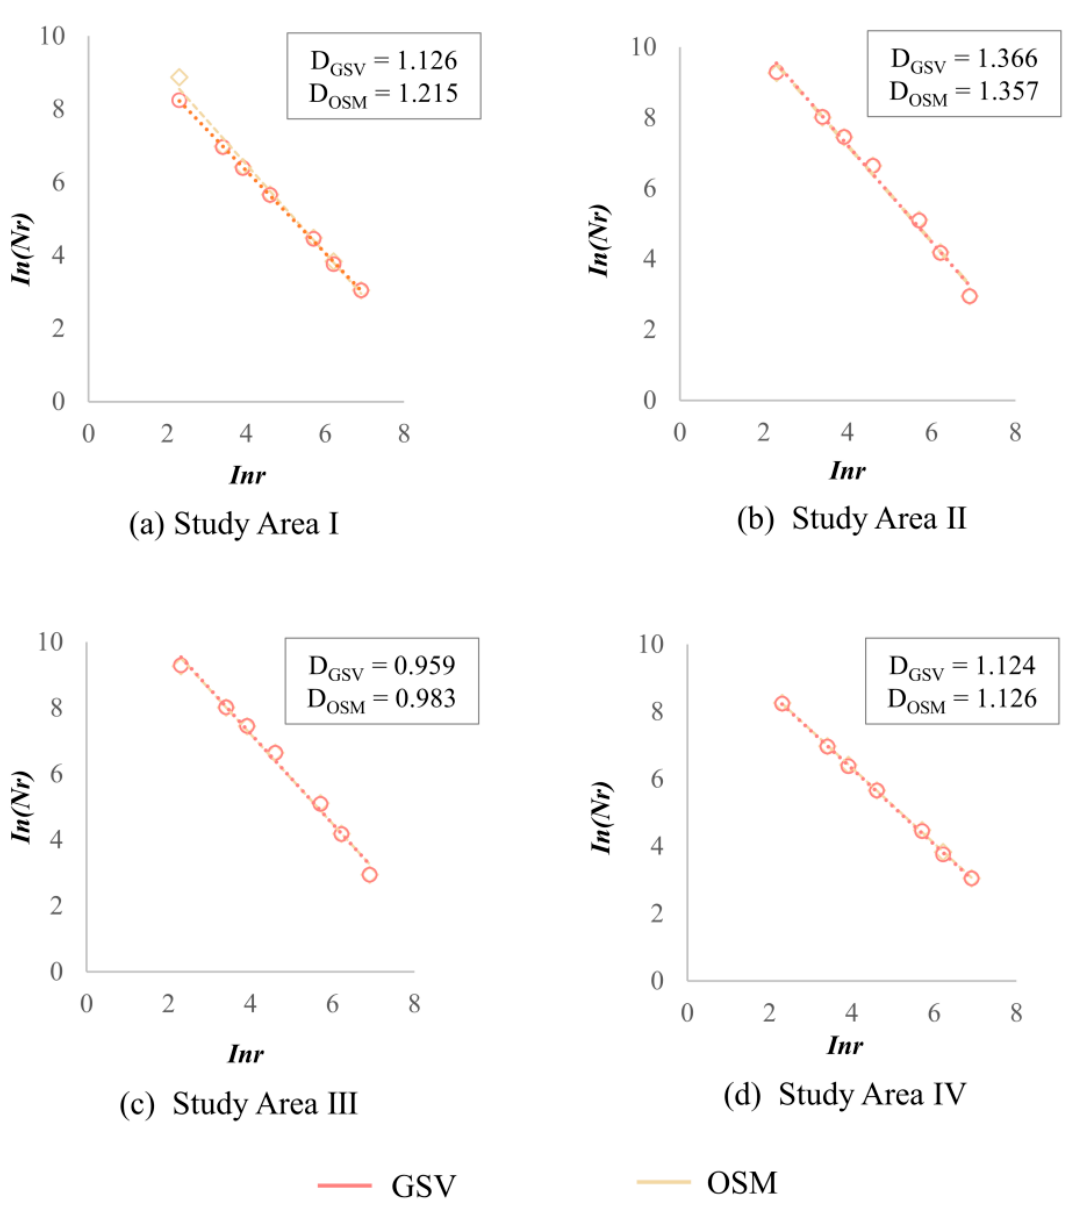
Figure 9. Results of the box-counting method and corresponding fractal dimensions, in terms of the two island datasets (OSM and GSV) and the four study areas (I, II, III and IV).